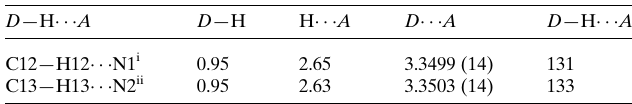
Table 1 Selected bond and torsion angles ( (cid:3) ) for 1a .